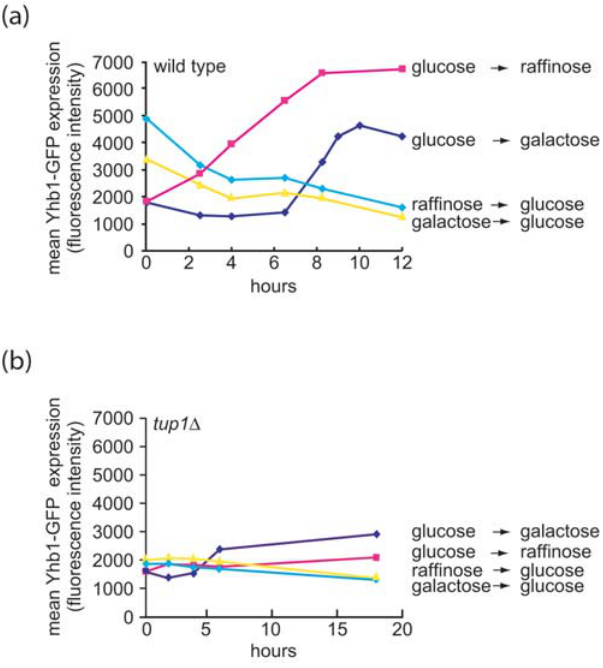
Figure 4. Glucose repression and derepression of Yhb1p-GFP measured by flow cytometry. (a) wild type strain. (b) tup1 deletion strain. To calculate a mean GFP intensity, a minimum 100,000 cells were measured for each time